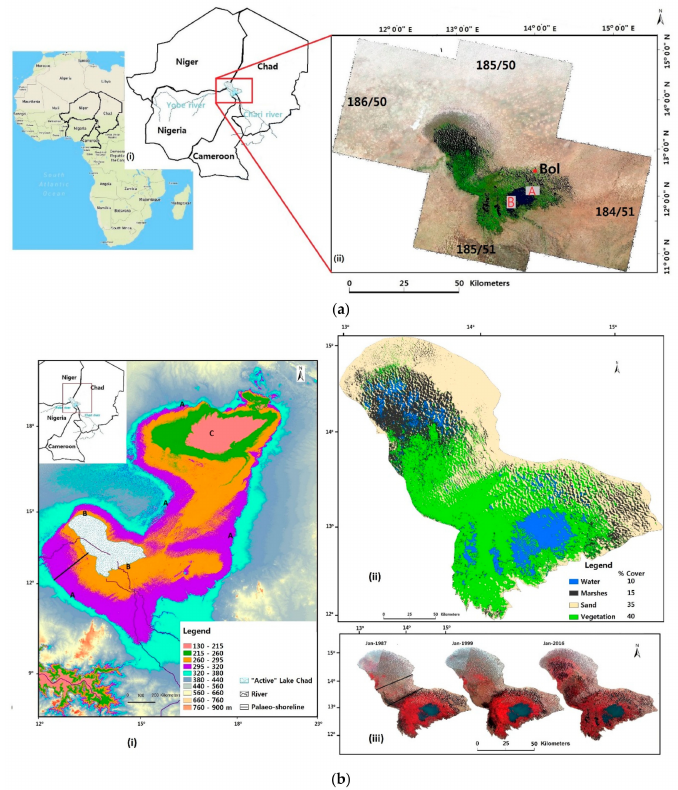
Figure 1. ( a ) (i) Location of Lake Chad Basin with area of permanent water. (ii) Four Landsat images with their respective Path/Row mosaicked to form a complete study site. Point A and B represents the locations of the high-resolution reference data. Bol is the closest village to the lake where most ground hydrological measurements collected by the LCBC. ( b ) (i) SRTM30 DEM of the Lake Chad Basin. A and B represents the shoreline of the “mega” and “active” Lake Chad respectively. The active Lake Chad shoreline has an elevation of about 290 m a.s.l. C is the lowest point within the basin. (ii) Averaged landcover types for July–December 2016 (iii) False color composite image produced using a combination of Landsat TM (4, 3, 2) and OLI (5, 4, 3) bands. The bars in the January-1987 image represent the split described by